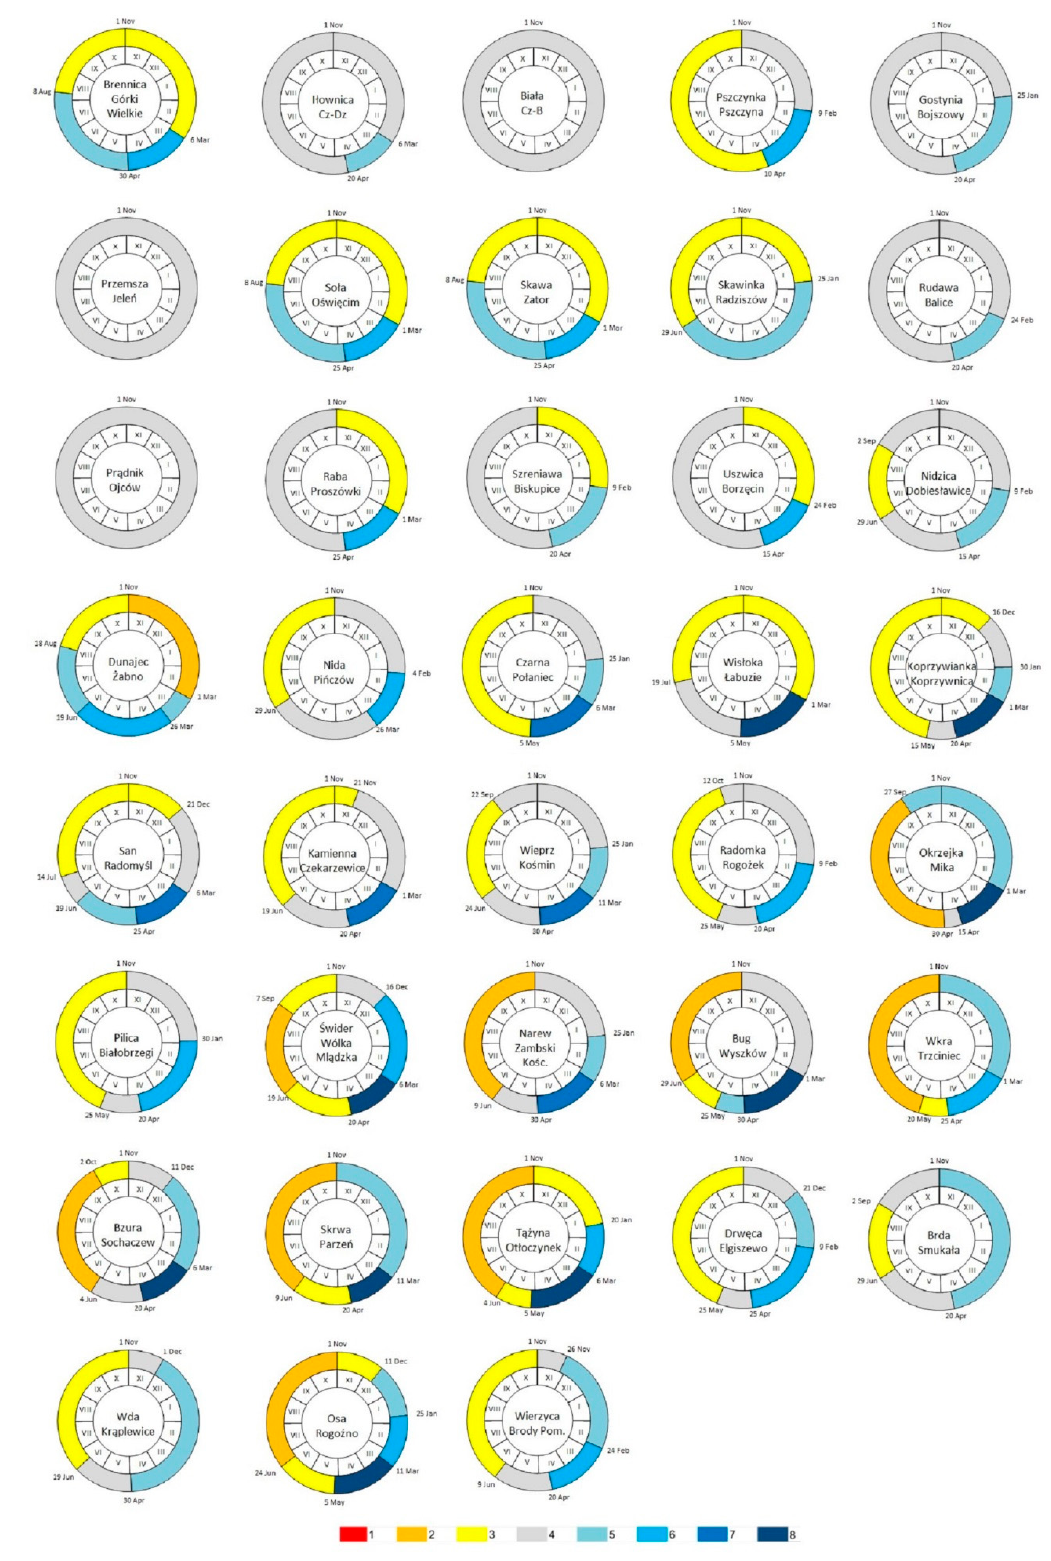
Figure 8. Sequence of hydrological periods in average annual cycle in 38 gauges on the Vistula River tributaries. Types of hydrological periods: 1—deep low-water, 2—average low-water, 3—shallow low-water, 4—normal period, 5—low high-water, 6—average high-water, 7—high high-water, 8—very high high-water.